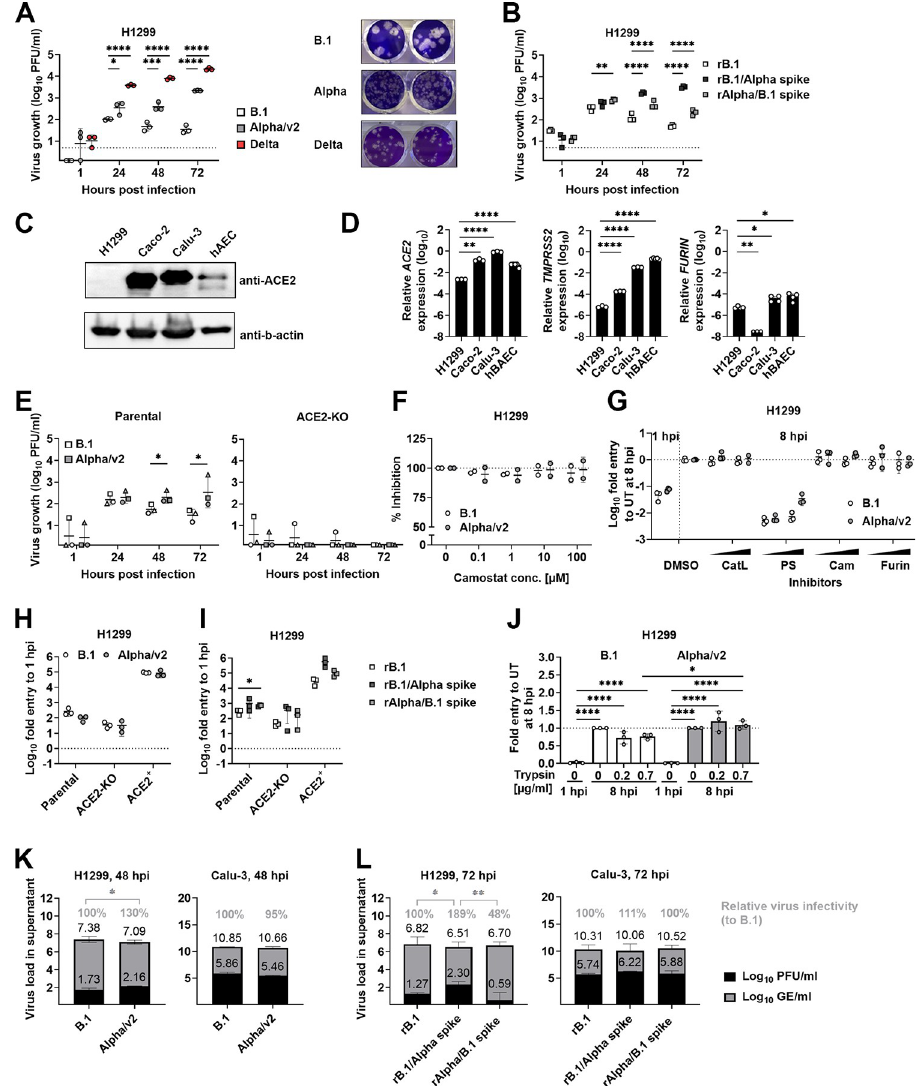
Fig 7. VOC Alpha and Delta display a postentry, spike-dependent replication advantage in NCI-H1299 cells, a human bronchial cell line with undetectable ACE2 protein level. ( A ) Virus growth of B.1, VOC Alpha, and Delta was assessed on NCI-H1299 cells. Cells were infected (MOI 0.01) and supernatants of indicated time points were titrated on Vero E6 cells (left panel). Plaque morphology of NCI-H1299-derived B.1, VOC Alpha, and Delta on Vero E6 cells is shown (right panel). Results from 1 representative experiment out of 3 is shown. ( B ) NCI-H1299 cells were infected with rB.1, rB.1/Alpha spike, or rAlpha/B.1 spike viruses (MOI 0.01) and supernatant was titrated on Vero E6 cells. The growth experiment was performed once in triplicates. ( C ) ACE2 expression levels were analyzed by immunoblotting. Beta-actin was used as a loading control. ( D ) Expression of ACE2 , TMPRSS2 , and FURIN was quantified by Q-RT-PCR in indicated cells. ( E ) Virus growth of B.1 and VOC Alpha was investigated on parental- NCI-H1299 (left) and respective ACE2-KO (right) cells. Cells were infected (MOI 0.01) and supernatants of indicated time points were titrated on Vero E6 cells. Three independent experiments, each in triplicates, were performed and are indicated by symbols. ( F ) NCI-H1299 cells were treated with increasing amounts of camostat mesylate (0–100 μ M) for 2 hours at 37˚C prior to infection with B.1 and VOC Alpha (MOI 0.01). After infection for 1 hour at 37˚C, camostat mesylate was replenished to the infection medium and cells were incubated for 48 hours. Virus replication was determined from the supernatant by E gene assay. All values were normalized to the respective B.1 or VOC Alpha- infected, untreated control cells (dotted line at 100%). The experiment was performed once in duplicates. ( G ) NCI-H1299 cells were pretreated for 2 hours at 37˚C prior to infection with B.1 and VOC Alpha (MOI 2) with MDL28170 (Cathepsin L inhibitor, 12.5 and 25 mM), pitstop II (clathrin inhibitor, 12.5 and 25 μ M), camostat mesylate (TMPRSS2 inhibitor, 50 and 100 μ M), or CMK (furin inhibitor, 2.5 and 5 μ M). Entry efficiency was determined at 8 hours postinfection from cell lysates by sgN Q-RT-PCR. The experiment was performed once in triplicates. ( H , I